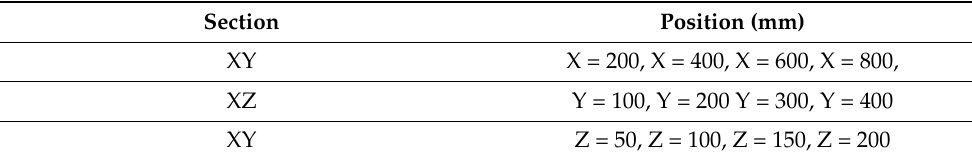
Table 8. Distribution of concentrations exceeding 25% of the LFL on the YZ section.